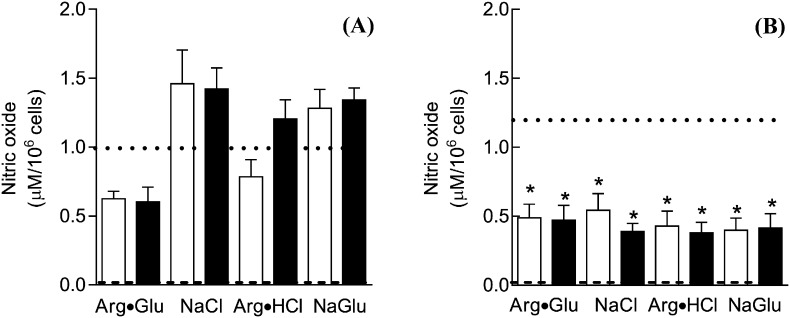
Impact of Arg·Glu and other salts on THP-1 cell nitric oxide productionTHP-1 cells were seeded into 24-well plates at 106 cells/mL in serum free RPMI media and were cultured for 24 h at 37 °C in medium alone (represented by the dashed line) or in the presence of 50 mM (open column) or 100 mM (closed column) Arg·Glu, NaCl, Arg·HCl or NaGlu. Supernatants (A) and lysates (B) were collected after the 24 h incubation and the nitrite concentration was determined by the Griess assay. The nitric oxide content of the media (with supplements) in the absence of cells was also determined (dotted line). The nitrite concentrations were determined using a nitrite standard reference curve and the associated computer software for microplate-based assays and data are displayed as nitrite concentration (μM; mean and SE). The statistical significance of differences in the nitrite content of samples from cells cultured in medium alone and cells treated with various concentrations of salts was assessed by one way ANOVA (*p < 0.05).